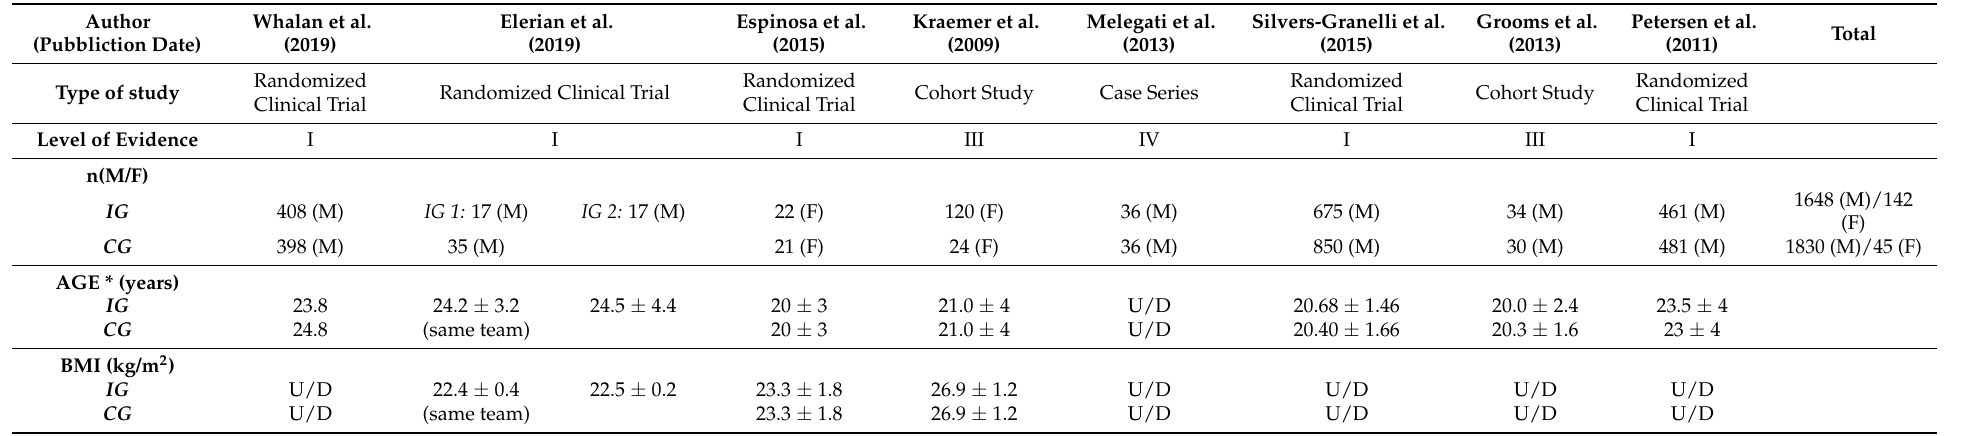
Table 1. Details of the studies included in the